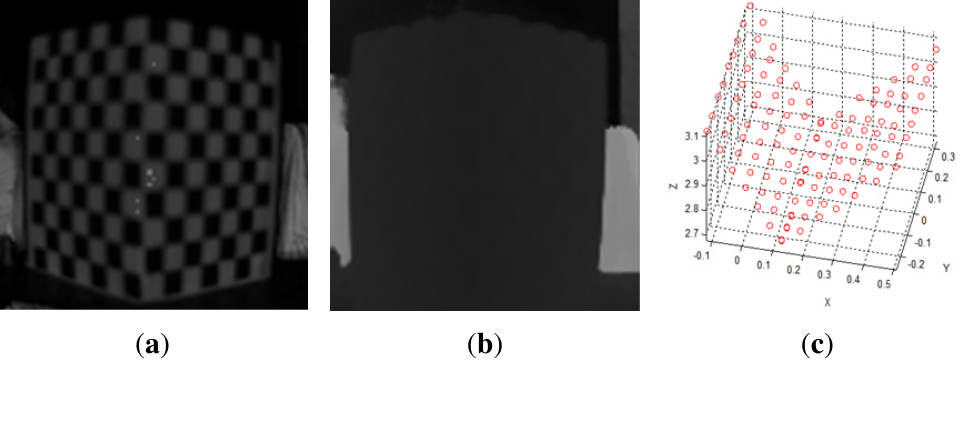
Figure 8. 3D points from the ToF camera: ( a ) near-IR image of the calibration rig from the ToF camera; ( b ) distance image of the calibration rig from the ToF camera; ( c ) extracted 3D coordinates of the calibration rig at the corner point of the check pattern in the near-IR